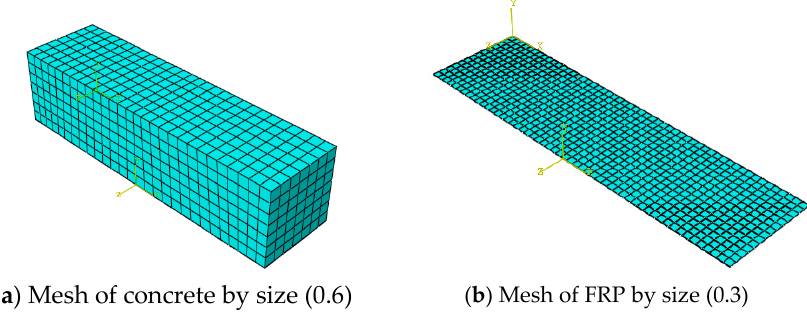
Figure 1. Mesh of concrete beam and FRP strengthening sheet. ( a ) Mesh of concrete by size (0.6); ( b ) Mesh of FRP by size (0.3).